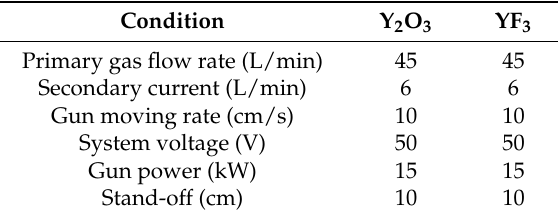
Figure 1. Schematic illustration of the cross section of inductively coupled plasma (ICP) etching tool. Table 1. Spraying parameters for coatings made of Y 2 O 3 and YF 3 .